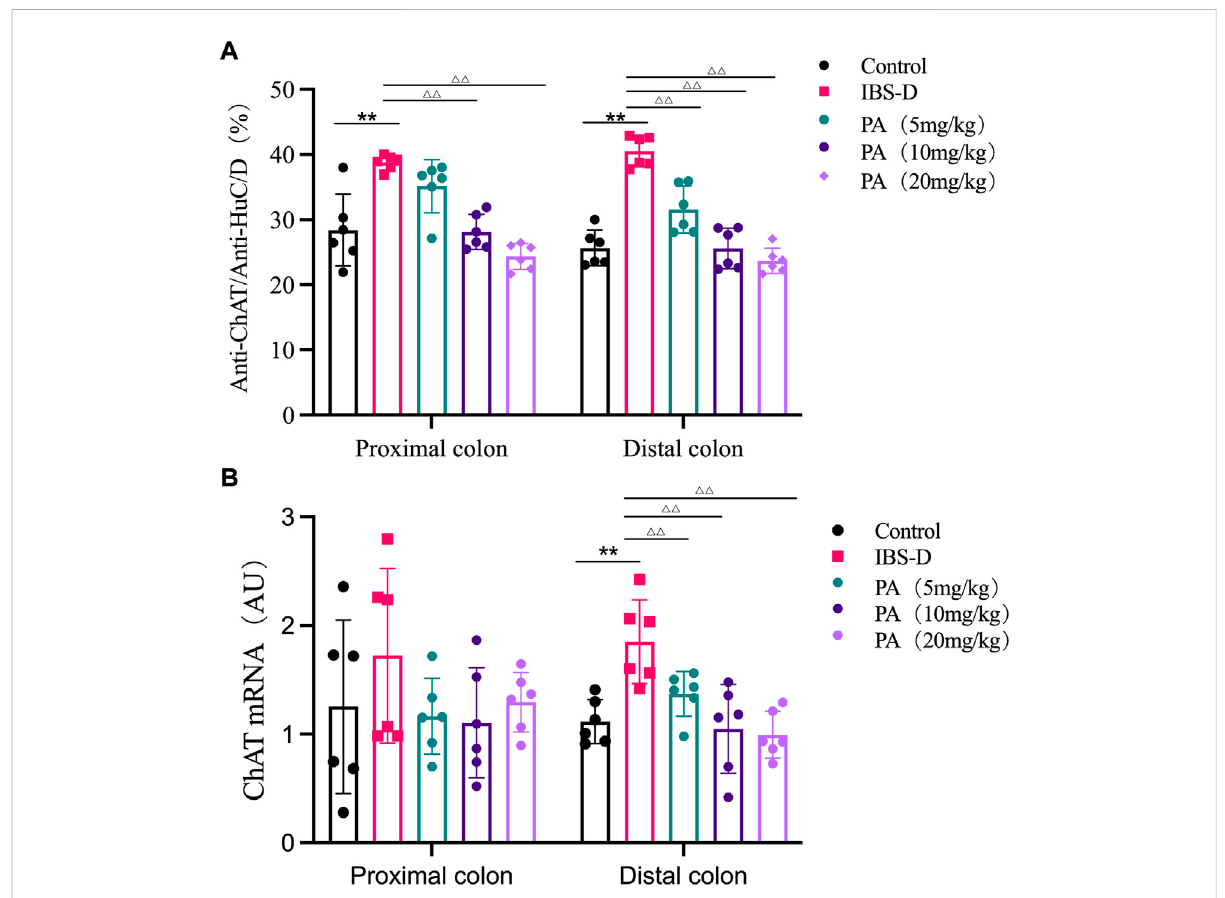
FIGURE 10 (A) The proportion of ChAT positive neurons in the distal and proximal colon of PA groups. (B) ChAT mRNA expression in PA groups. RNA was isolated with TRIzol reagent and qRT-PCR was utilized to analyze the gene expression of ChAT. The GAPDH gene was used as internal reference. Data are presented as mean ± SD ( n = 6). * p < 0.05, ** p < 0.01, vs. controls. △ p < 0.05, vs. models, △△ p < 0.01, vs.